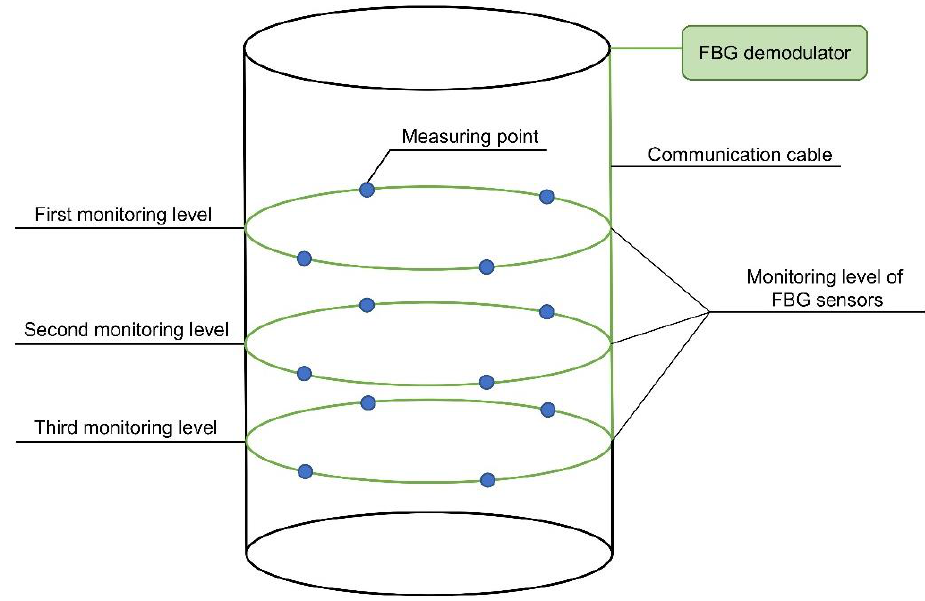
Figure 11. Schematic diagram of FBG monitoring system for shaft lining structure.